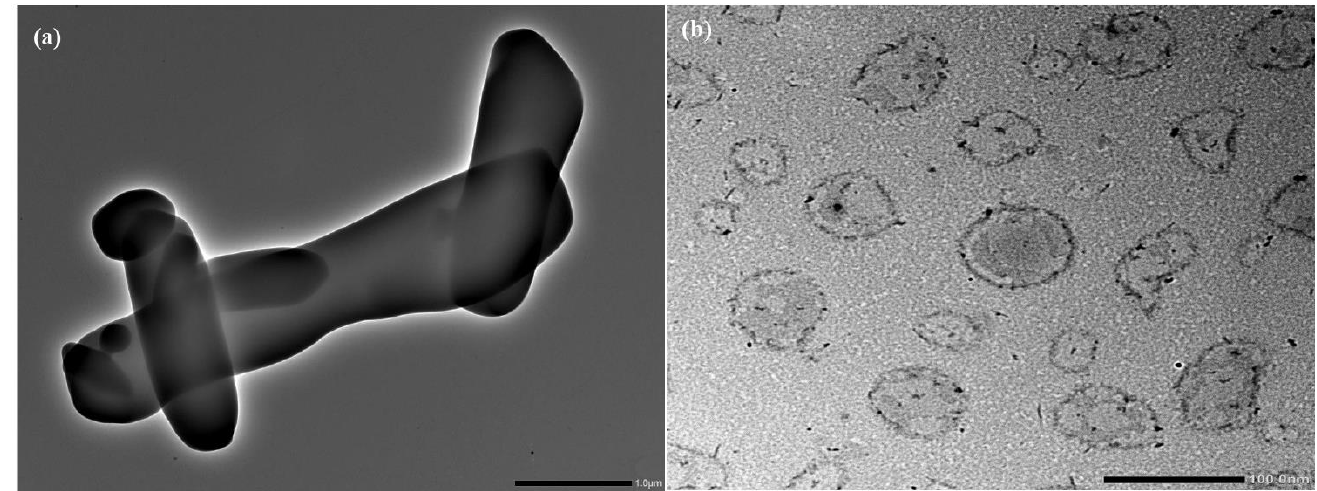
Figure 4. ( a ) Surface morphology of pure RTG by TEM, ( b ) Surface morphology of optimized RTG-LCNP by TEM.